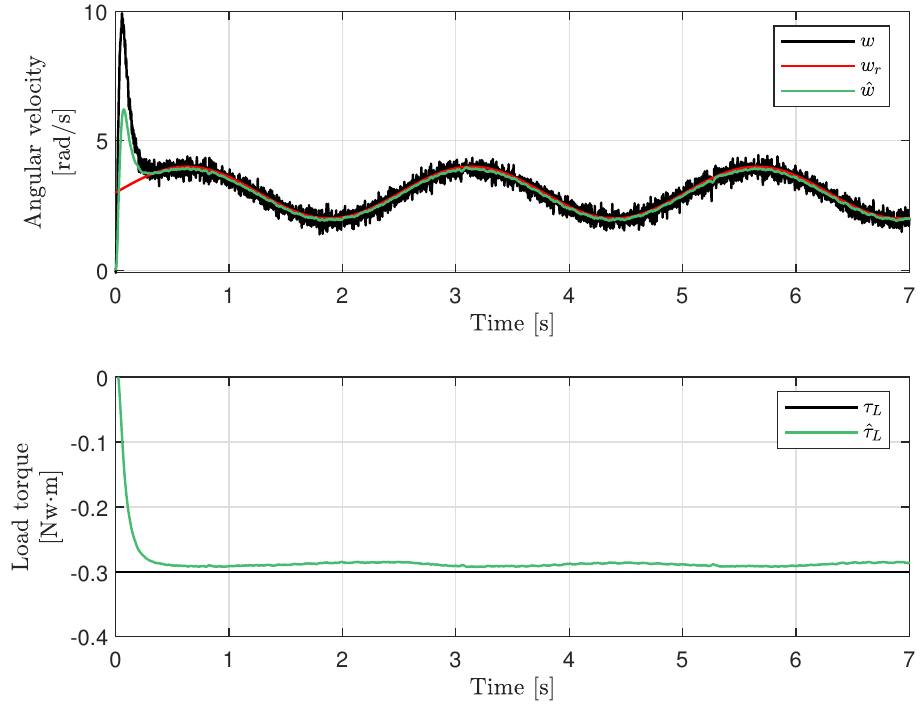
Figure 5. Variable and parameter estimations for the case λ = 1 and matrix Q = 10 I 4 .